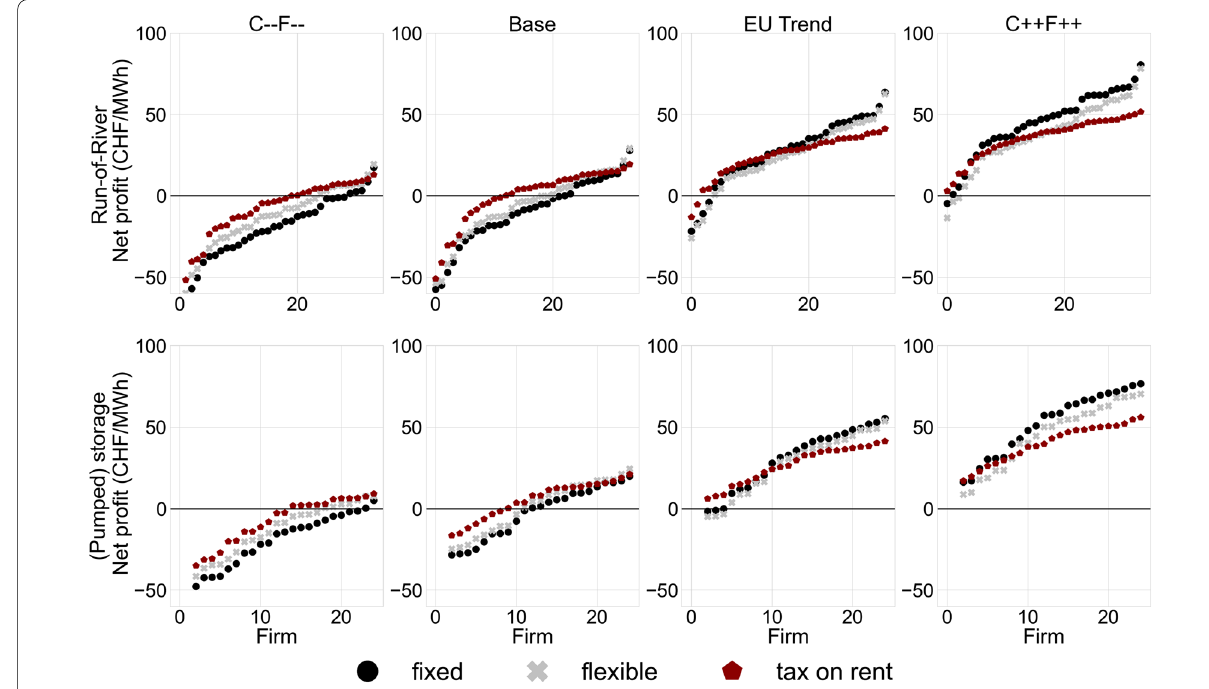
Fig. 5 Net profits of all companies in our sample in